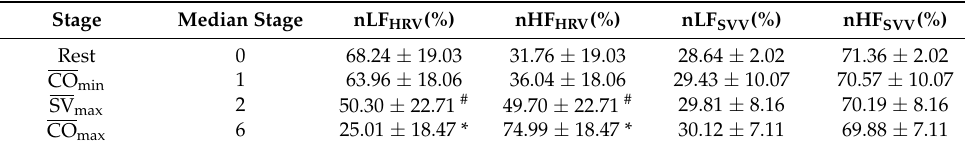
Table 3. The result and comparison of normalized low frequency (nLF) and high frequency (nHF) with heart rate variability (HRV) and stroke volume variability (SVV) in different stages during incremental exercise and rest.